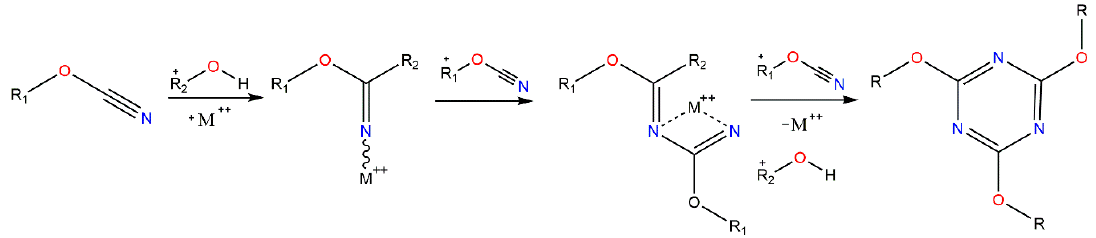
Figure 1. Self-polymerization mechanism of cyanate ester in the presence of catalysts.